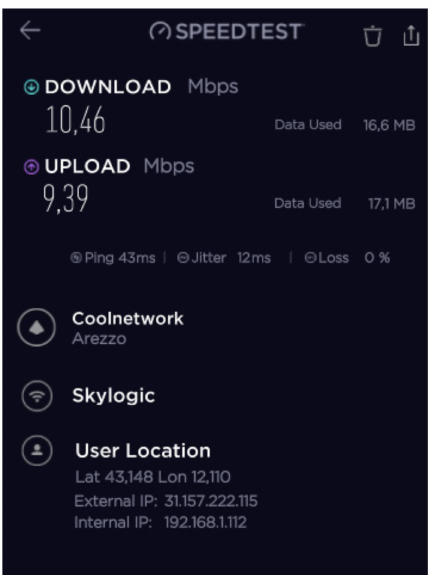
Figure 16. B-LiFE deployment in Turin, Italy, during the COVID-19 crisis: speed test results for the 4G/LTE (Vodafone IT) modem.